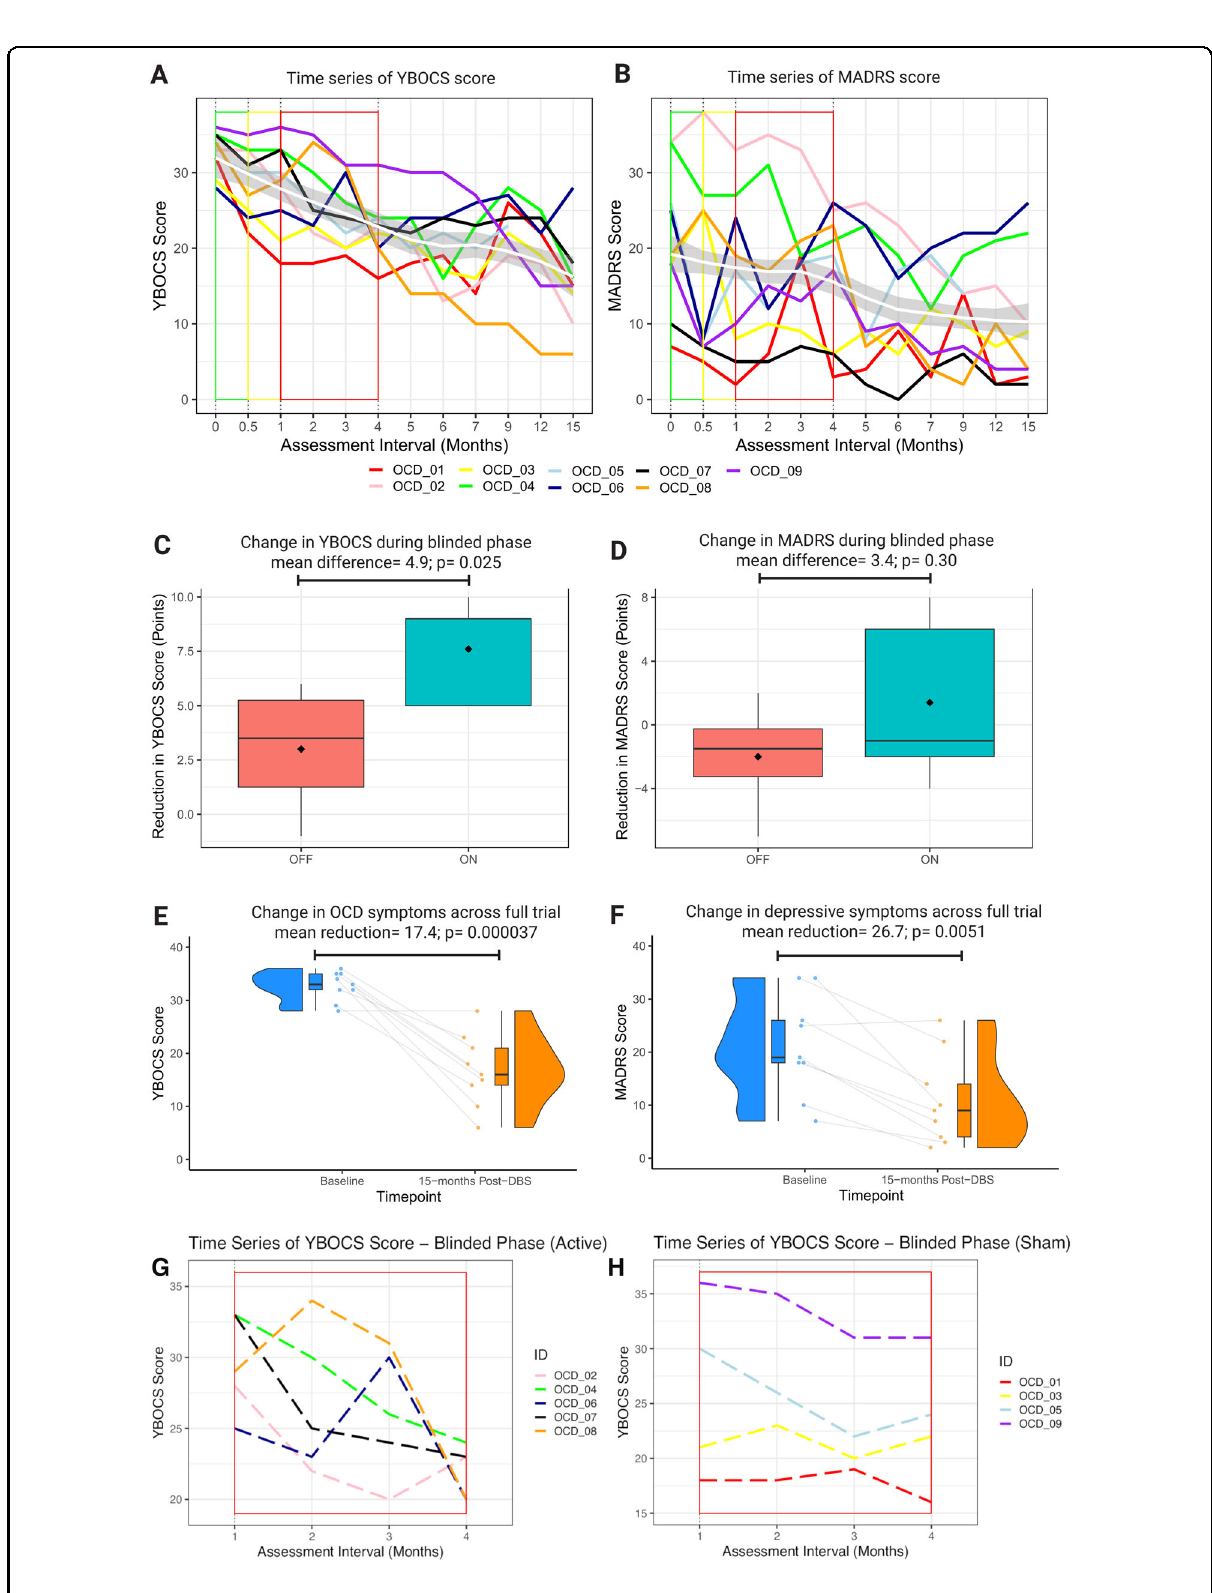
Fig. 3 (See legend on next